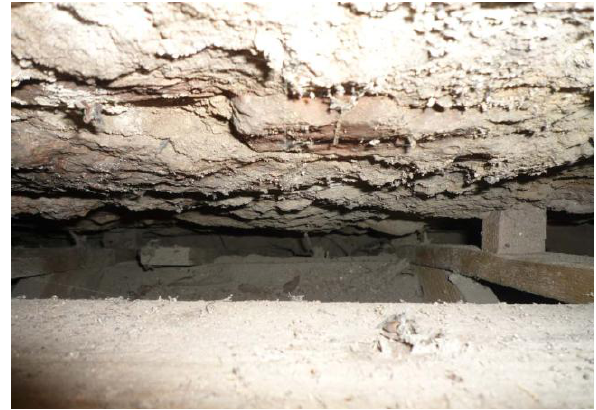
Figure 3. View inside the cavity wall before insulation